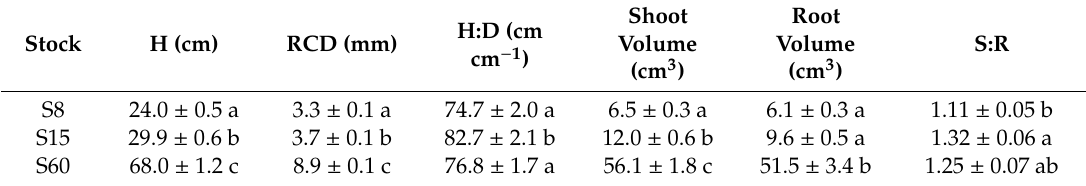
Table 2. Initial seedling height (H), root-collar-diameter (RCD), height to root collar diameter ratio (H:D), shoot volume, root volume and shoot to root volume ratio (S:R) of styro-8 (S8), styro-15 (S15), and styro-60 (S60) Douglas-fir seedlings. Values after ± represent standard error. Within a